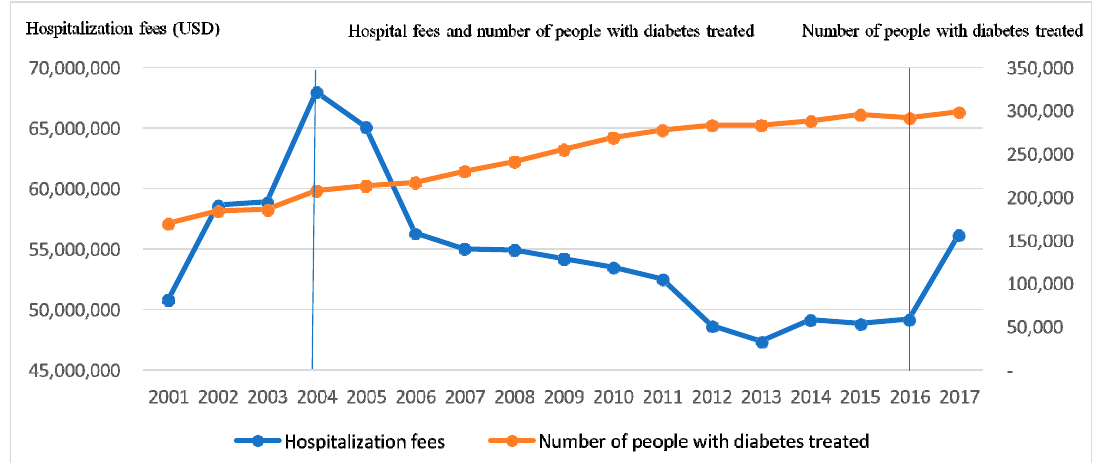
Figure 3. Hospitalization medical fees and number of people with diabetes treated.